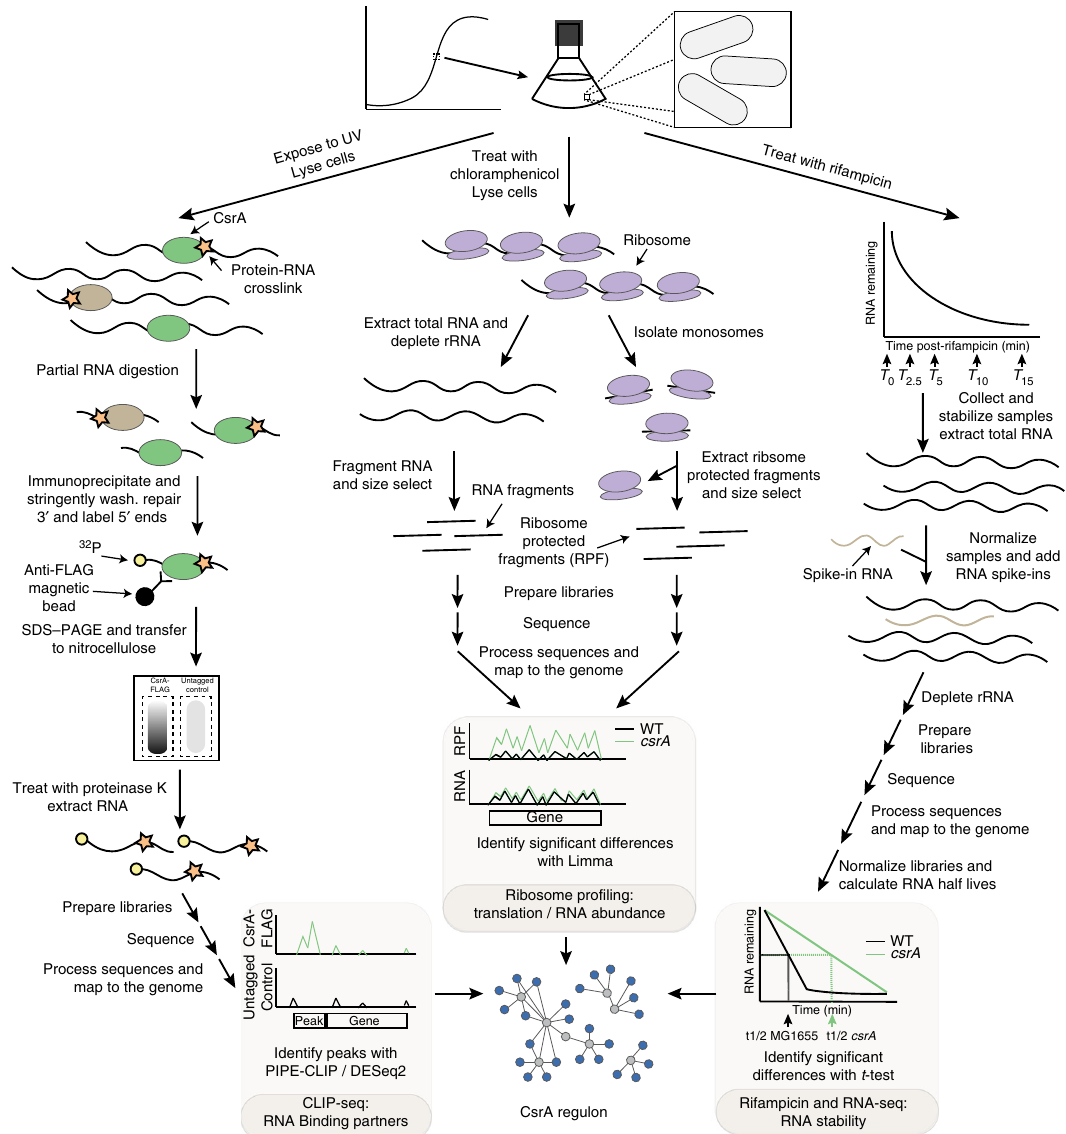
Fig. 1 Overview of integrated transcriptomic approaches. Three transcriptomics methods were used to investigate the role of CsrA in gene expression during mid-exponential growth in LB media: UV crosslinking, immunoprecipitation and sequencing (CLIP-seq) (left), ribosome pro fi ling and paired RNA- seq (center), and RNA-seq with rifampicin inhibition of transcription initiation (right). For CLIP-seq analysis, cells were treated with UV light to induce protein – RNA crosslinks, washed, and lysed. The lysate was treated with RNase I to trim the RNA. Then, the crosslinked RNA was co-immunoprecipitated and radiolabeled at the 5 ′ end. The protein – RNA complexes were separated using SDS – PAGE and transferred to a nitrocellulose membrane. Following proteinase K treatment, the crosslinked RNA was puri fi ed, and used to create sequencing libraries. The processed and mapped sequences were used to identify peaks signi fi cantly enriched in 3xFLAG-CsrA samples. For ribosome pro fi ling, cells were treated with chloramphenicol to stall transcription elongation and then quickly lysed under conditions that maintain ribosome integrity. Part of the lysate was treated with micrococcal nuclease, and ribosomes were isolated with ultracentrifugation over a sucrose cushion. Ribosome-protected fragments (RPF) were then puri fi ed. Total RNA was also extracted from a different portion of the same lysate, depleted of rRNA, and fragmented. RPF and RNA samples were size selected and used to create sequencing libraries. Processed and mapped sequences were analyzed to identify changes in translation (RPF), RNA abundance (RNA), and translational ef fi ciency (RPF and RNA) between the wild-type (WT) and csrA mutant strains. For the analysis of RNA stability, samples were collected at fi ve time points following the addition of rifampicin to cultures to prevent transcription initiation. Total RNA was extracted and an RNA spike-in containing exogenous sequences of known abundances was added to aid data normalization. rRNA was depleted and sequencing libraries were prepared. Processed and mapped sequences were normalized using the spike-in RNA reads. Then, RNA stability was modeled using linear regression on a semi-log plot. RNA half-lives were calculated and used to identify signi fi cant differences in RNA stability between the WT and csrA mutant